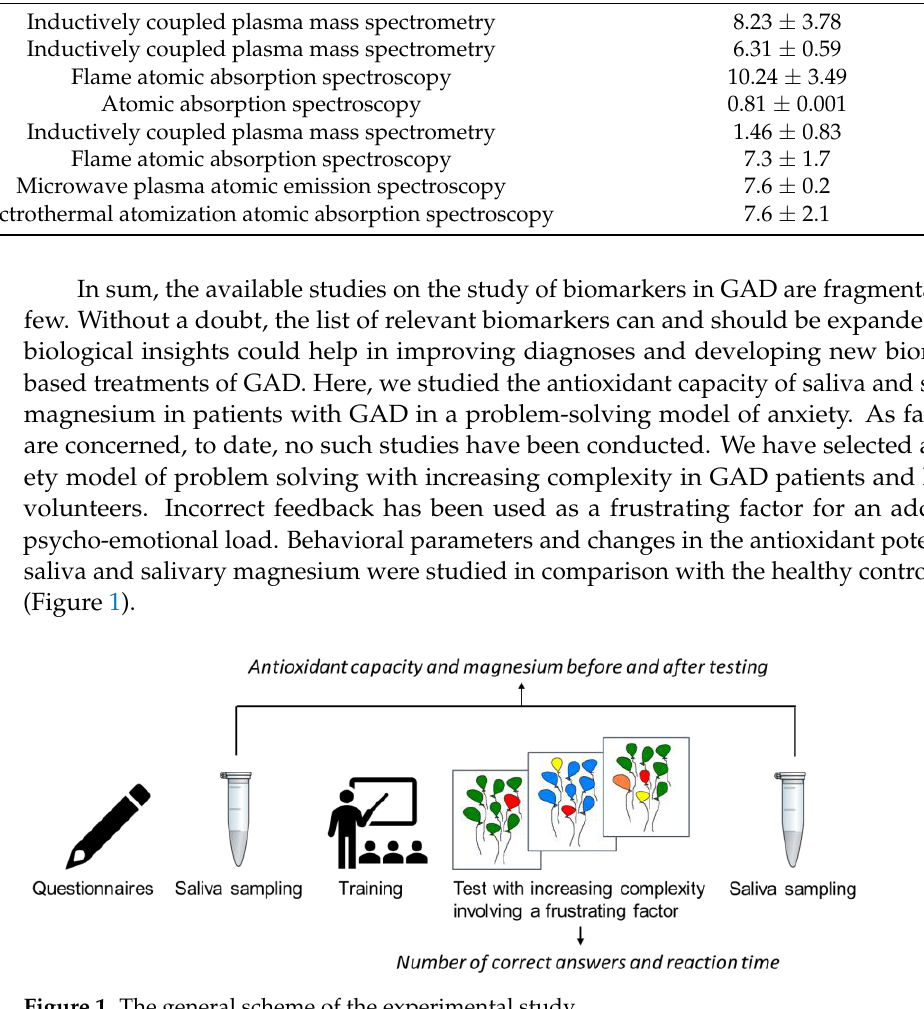
Figure 1. The general scheme of the experimental study.